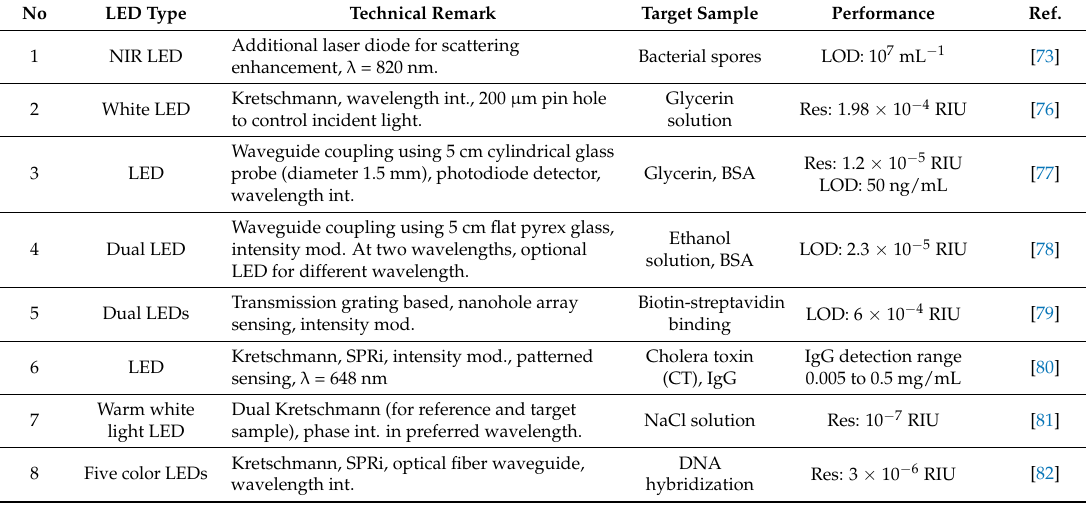
Table 4. The summary of the LED light source in SPR sensor